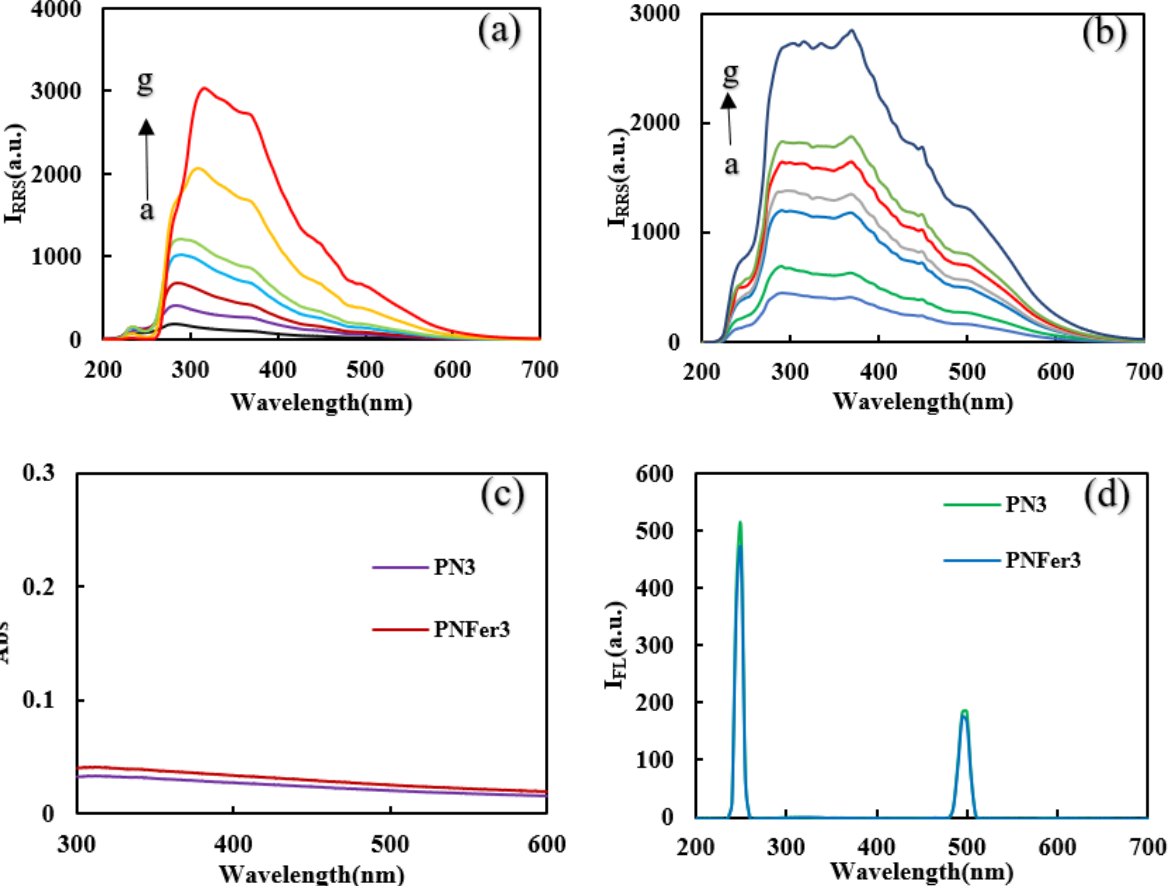
Figure 2. Electron microscope images and energy spectra of PN Fer and nanocatalytic analysis system. PN 3 , and the catalysis is enhanced. The more DNase formed, the stronger the catalytic ( a ) 6.67 mg/L PN 3 ; ( b ) 6.67 mg/L PN Fer3 ; ( c ) 6 nM HM + 8 nM Apt + 6.67 mg/L PN Fer3 + 0.67 mM AgNO 3 effect on the system, and the RRS signal increases linearly with the concentration of Pb 2+ . + 53.2 mM SF; ( d ) 1.0 nM Pb 2+ + 6 nM HM + 8 nM Apt + 6.67 mg/L PN Fer3 + 0.67 mM AgNO 3 + 53.2 mM Figure 6b,c are the RRS spectra of PN 3 /PN Fer3 and DNase for the detection of Pb 2+ . In SF. contrast, the PN Fer3 was the most sensitive, and was chosen for use.